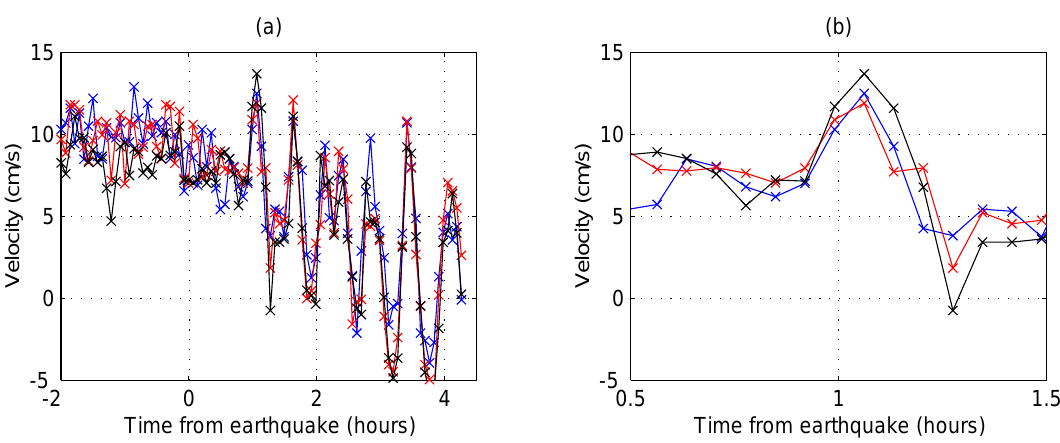
Figure 2. Time series of current velocity components from the Kinaoshi radar. Radial current velocities were resolved perpendicular to the area band boundaries, and averaged. Area bands used were 2 km wide and approximately parallel to the depth contours. Blue: 6–8 km; Red: 8–10 km; Black: 10–12 km. ( a ) From 2 h before the quake until 5 h after. ( b ) Around the tsunami